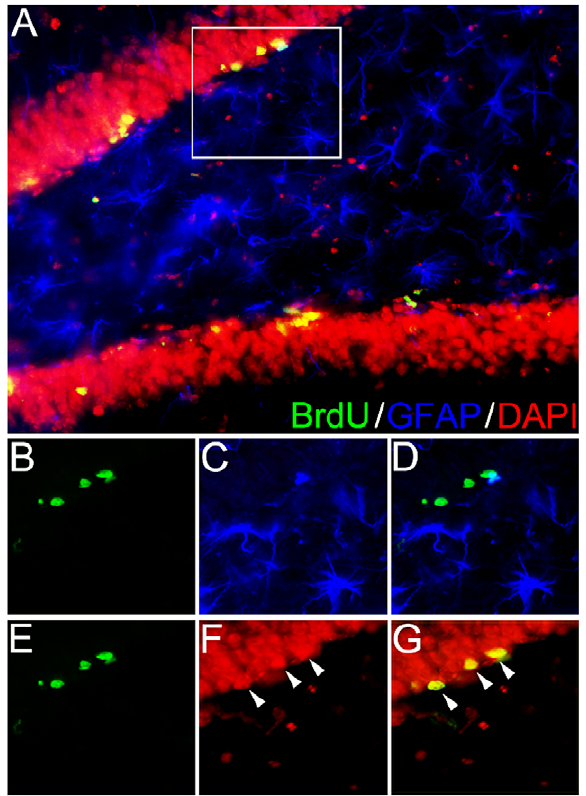
Figure 2. Gliogenesis is minimal in adult hippocampus. Hippocampal sections were immunostained for BrdU (green), GFAP (blue), and DAPI (red; color changed to red for purposes of visibility) to assess specificity of BrdU labeling and gliogenesis. (A) Representative photomicrograph (400 6 ) of the dentate gyrus of the hippocampus expressing all three labels. Tissue was double-labeled immunofluores- cently with antibodies against BrdU (B) and GFAP (C) to determine whether BrdU-labeled cells were glia (D). Approximately 2% of all BrdU- positive cells co-labeled with GFAP. In the triple-labeled image (D), three cells are labeled for BrdU, but do not co-express GFAP. Tissue was also labeled with fluorescent antibodies against BrdU (E) and DAPI (F) to ensure the specificity of BrdU labeling in mature neurons (G).